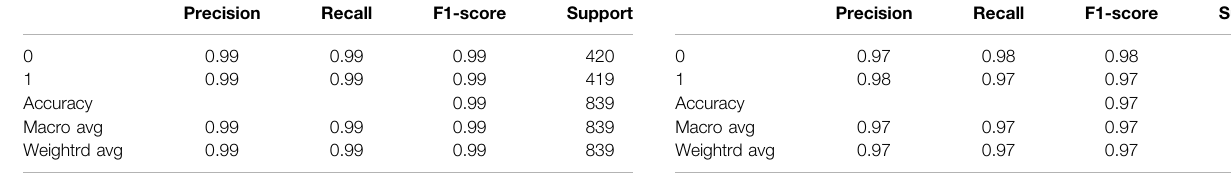
TABLE 2 | Evaluation indexes of textRNN model on the amino acid sequence.